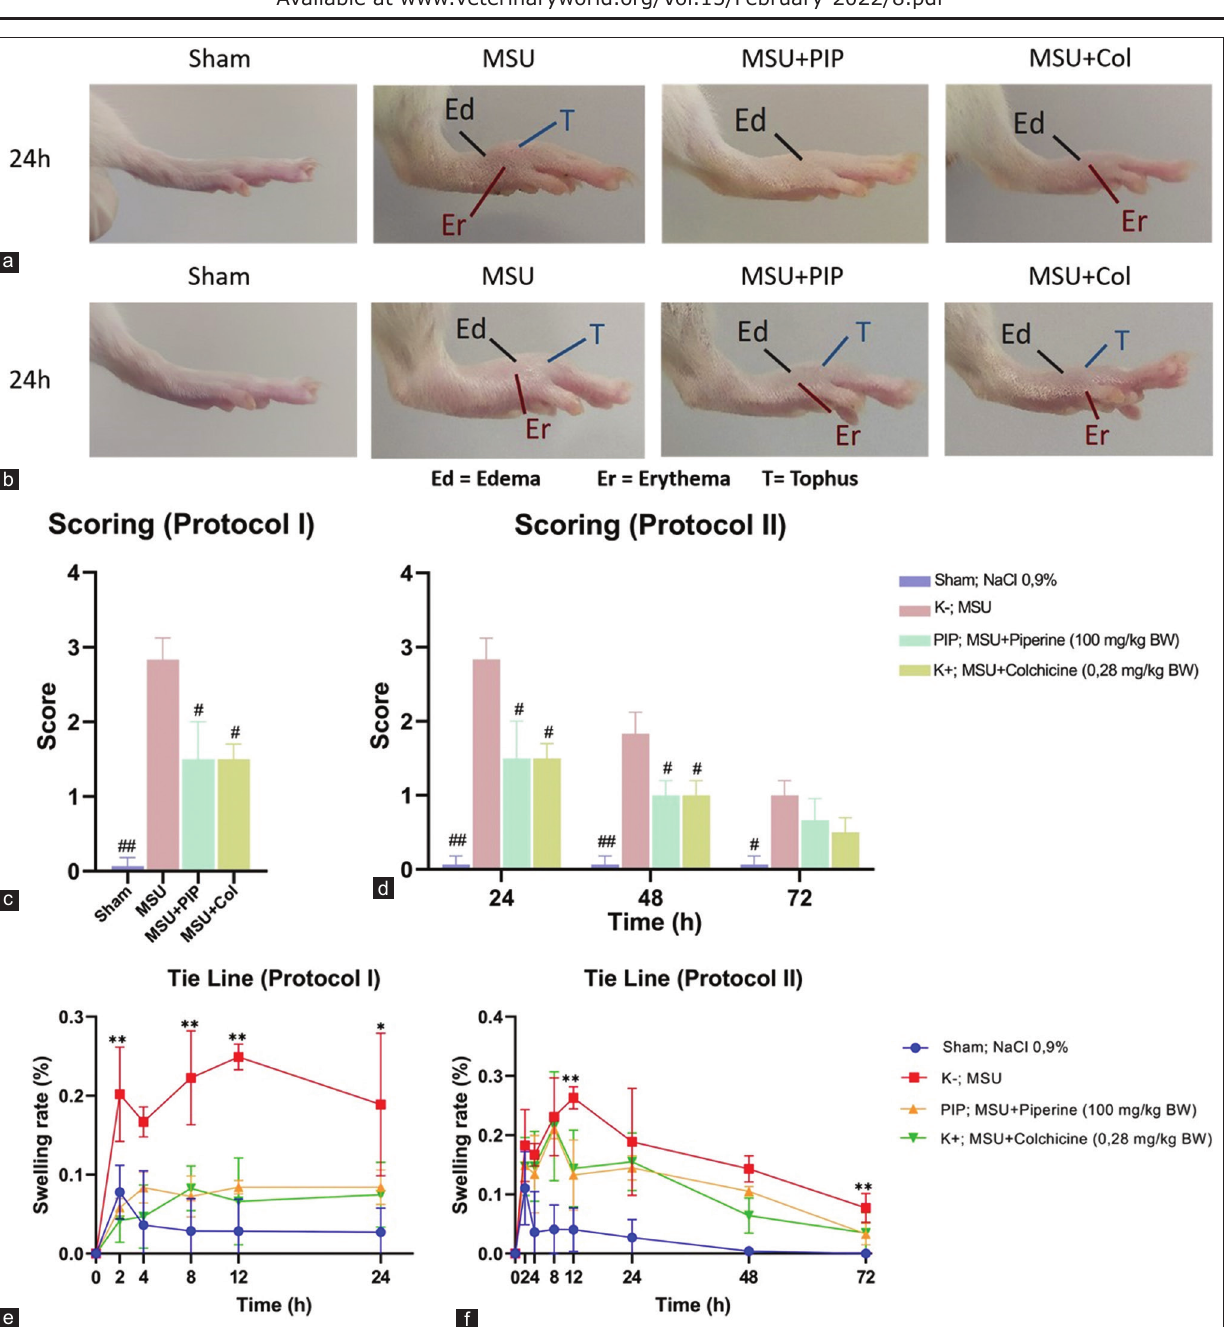
Fig ure-2: Oral administration of PIP suppresses gouty inflammation induced by injection of monosodium urate (MSU) crystals in rat plantar. (a, c, e) Anatomical assessment of inflammation in preventive protocol I. (b, d, f) Anatomical assessment of inflammation in curative protocol II (a) comparison of rat paw morphology of protocol I 24 h post-injection. (b) Comparison of rat paw morphology of protocol II 24 h post-injection. (c) Protocol I rat plantar inflammation scoring 24 h post-injection. (d) Protocol II rat plantar inflammation scoring 24, 48, and 72 h post-injection. (e) The swelling rate of protocol I rat paws was calculated using the tie line method at 2, 4, 8, 12, and 24 h post-injection. (f) The swelling rate of protocol II rat paws was calculated using the tie line method at 2, 4, 8, 12, 24, 48, and 72 h post-injection. Values on the graph are represented as mean±SD (n=3 rats/group). Significantly different from MSU group, # p<0.05, ## p<0.01; significantly different from sham, MSU+PIP, MSU+Col groups, *p<0.05, **p<0.01. MSU=Monosodium urate; PIP=Piperine; protocol I preparations demonstrated the protection of PIP against gout-induced cartilage erosion as observed